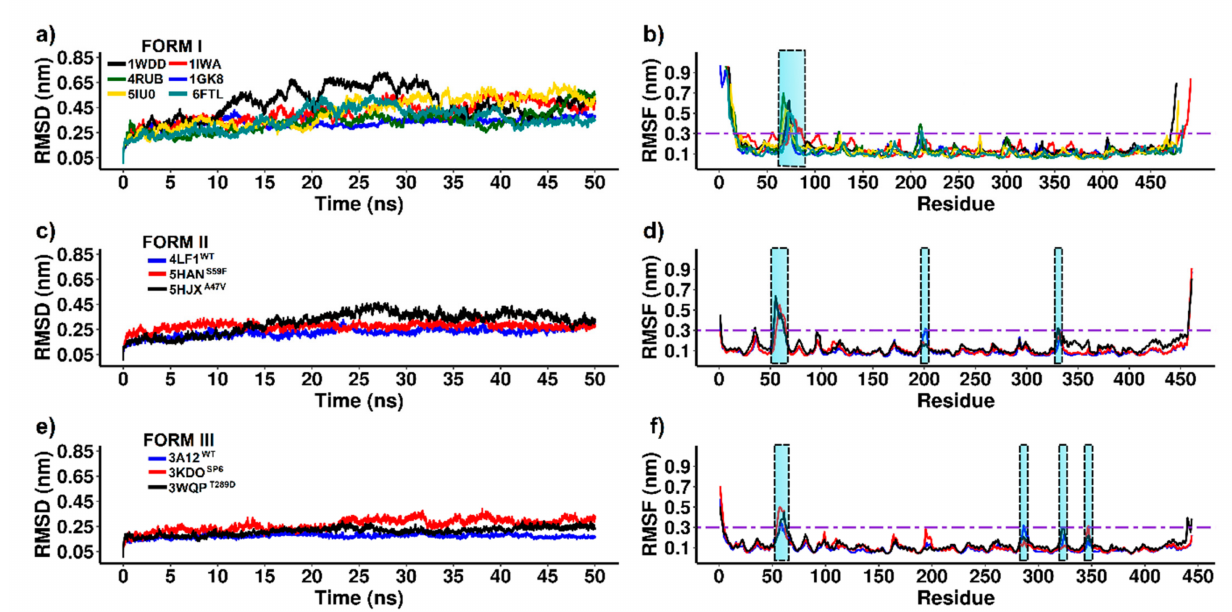
Figure 5. RMSD and RMSF profiles of RuBisCO forms I, II and III. ( a ) 50 ns RMSD of form I; ( b ) RuBisCO form I RMSF; ( c ) 50 ns RMSD of form II; ( d ) RuBisCO form II RMSF; ( e ) 50 ns RMSD of form III; ( f ) RuBisCO form III RMSF. RMSD was used to measure the deviations of the protein backbone from its original structural conformation to its final structural conformation. C-alpha atoms were used to calculate